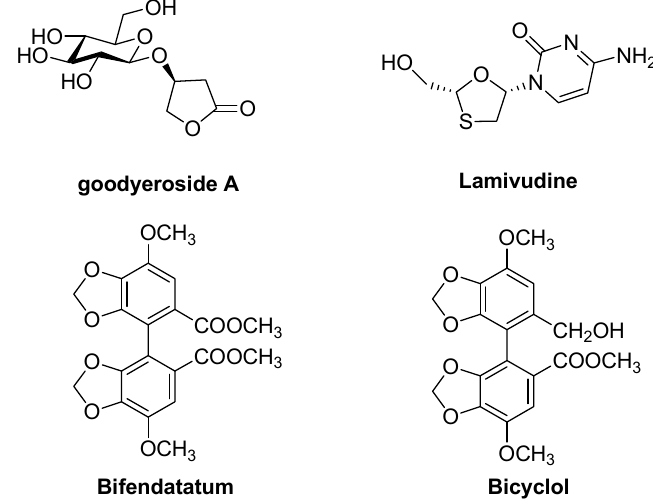
Figure 1. Goodyeroside A and some known drugs for hepatitis